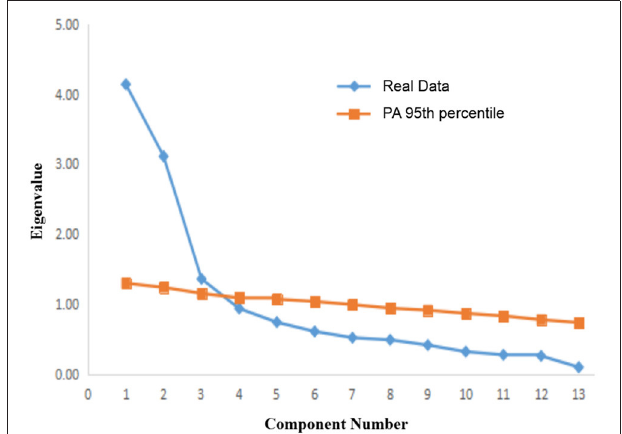
FIGURE 1 | Plot of the first 13 eigenvalues on PACQ for